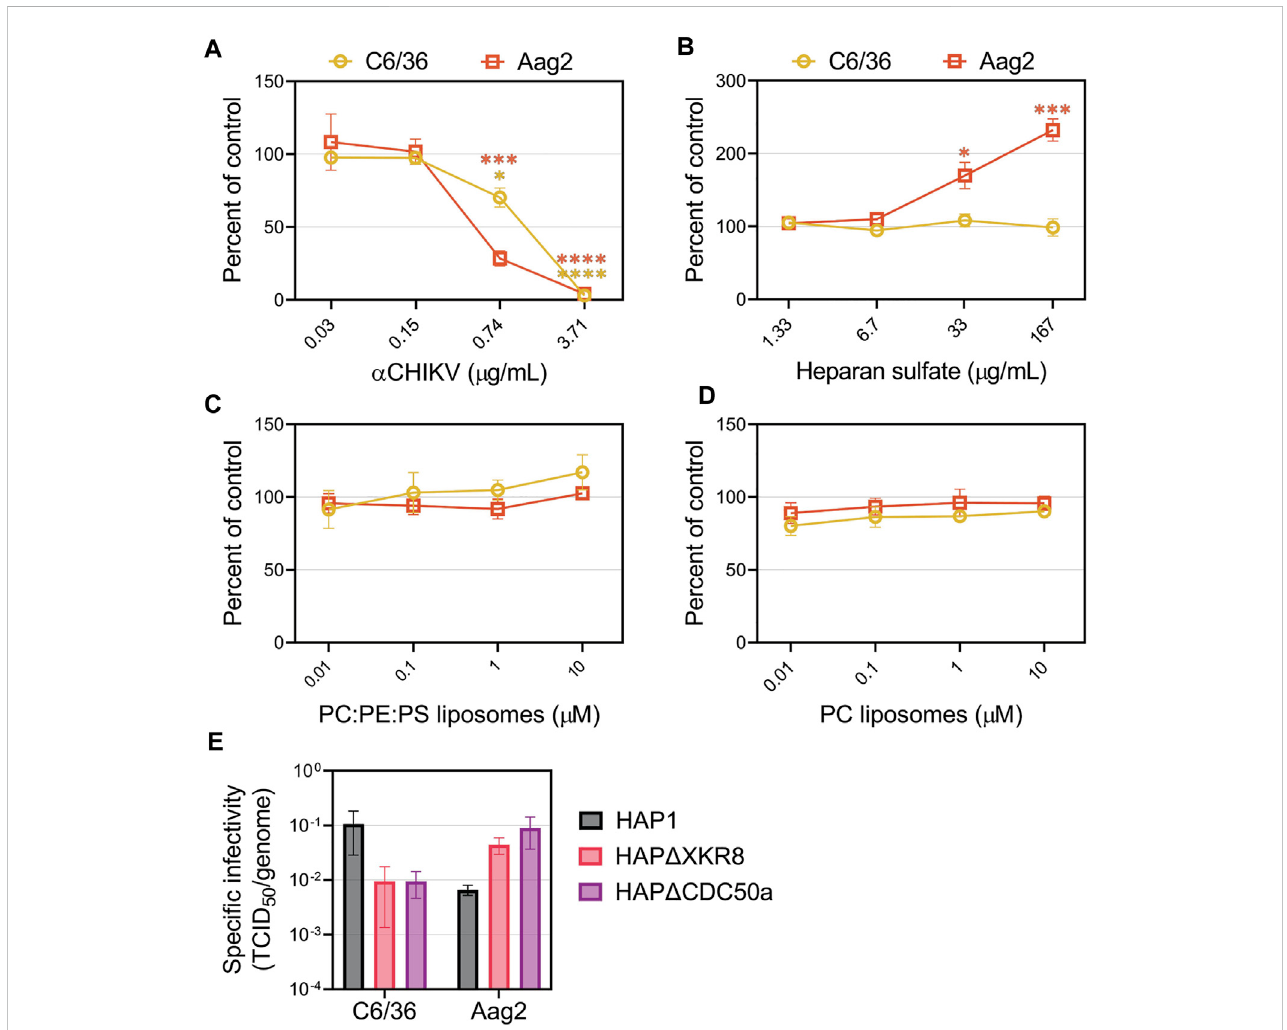
FIGURE 6 CHIKV infection in mosquito cells is not inhibited by the addition of heparan sulfate or liposomes. CHIKV stocks were used to assess the ability of (A) CHIKV antibody (B) heparan sulfate (C) PS-containing liposomes (75% PC: 20% PE: 5% PS) and (D) PC-only liposomes to block infections into either C6/36 or Aag2 mosquito cells atthe indicated concentrations. (E) The ratio of TCID 50 to genome copy equivalents for each sample was used to assess theinfectivity of particles produced from HAP1 cell lines on mosquito C6/36 and Aag2 cells. Infectivity values were natural log (ln) transformed prior to performing an unpaired parametric Student ’ s t-test between Δ XKR8 and Δ CDC50a conditions. Data are presented as the mean ± SEM from at least three independent experiments performed in triplicate. *, p < .05; ***, p < .001; ****, p <